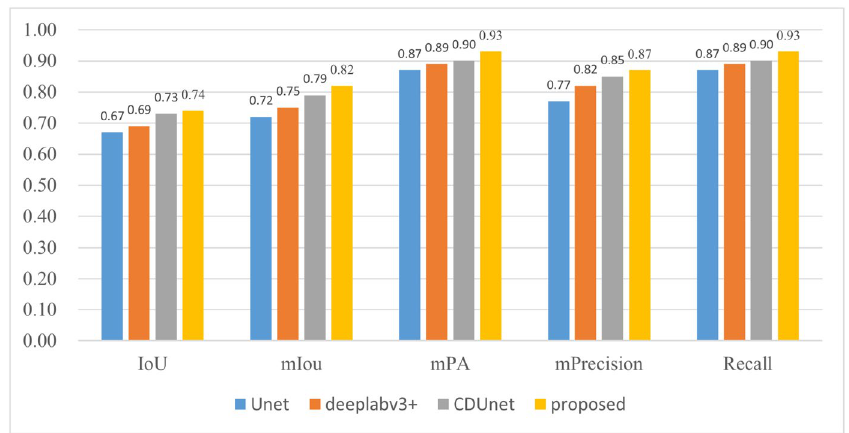
Figure 10. Comparison of evaluation results of IoU and other 5 quantitative indicators.